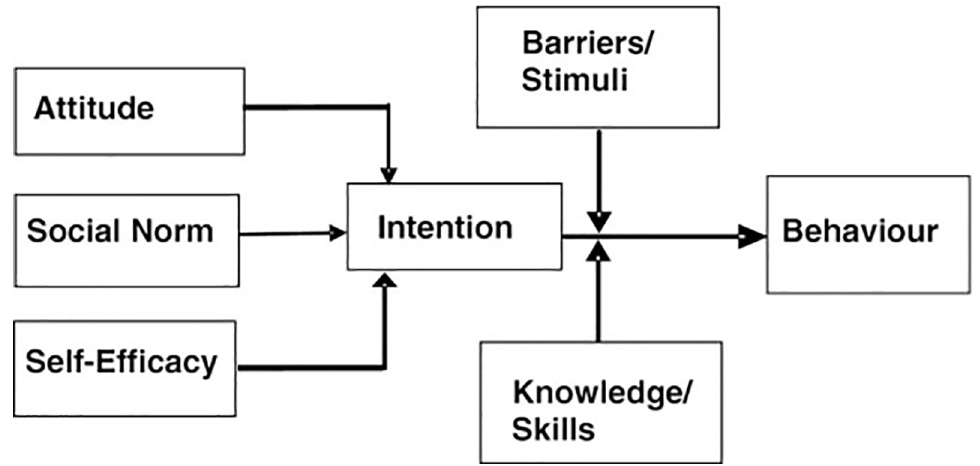
Fig 2. The ASE model which was applied to accomplish behavioral change in PCHC